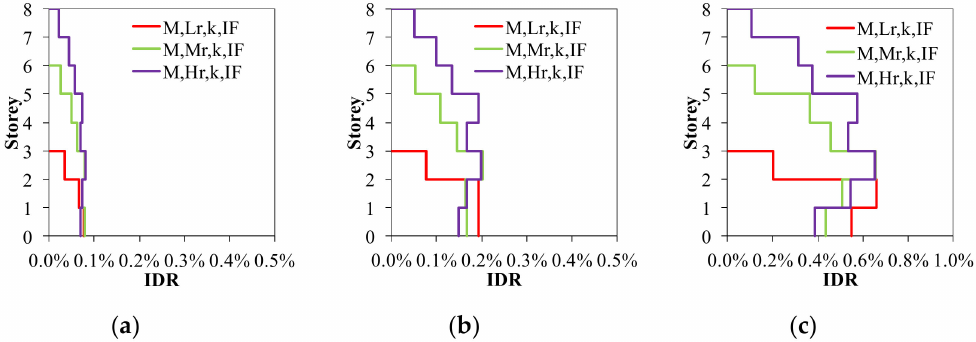
Figure 9. Maximum interstory drift profiles (computed as average between the two principal directions) at ( a ) ZL, ( b ) O, and ( c ) DC performance levels for the M-archetype buildings.